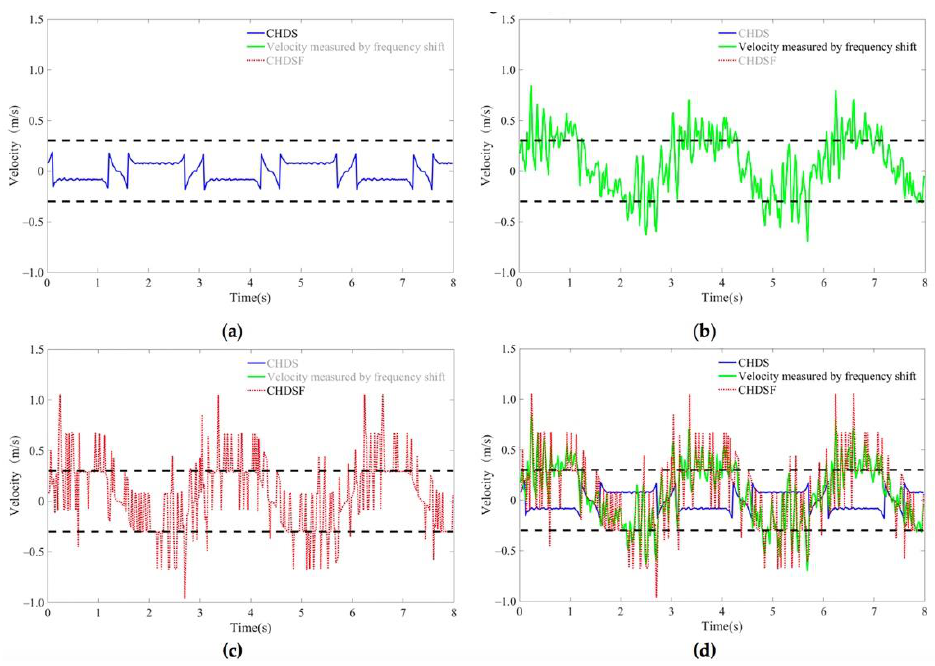
Figure 5. Measured speed of 0.300 m/s (black dash line) by CHDS, frequency shift and CHDSF: ( a ) velocity measured by CHDS; ( b ) velocity measured by frequency shift; ( c ) velocity measured by CHDSF; ( d ) comparison of velocities measured by 3 methods.